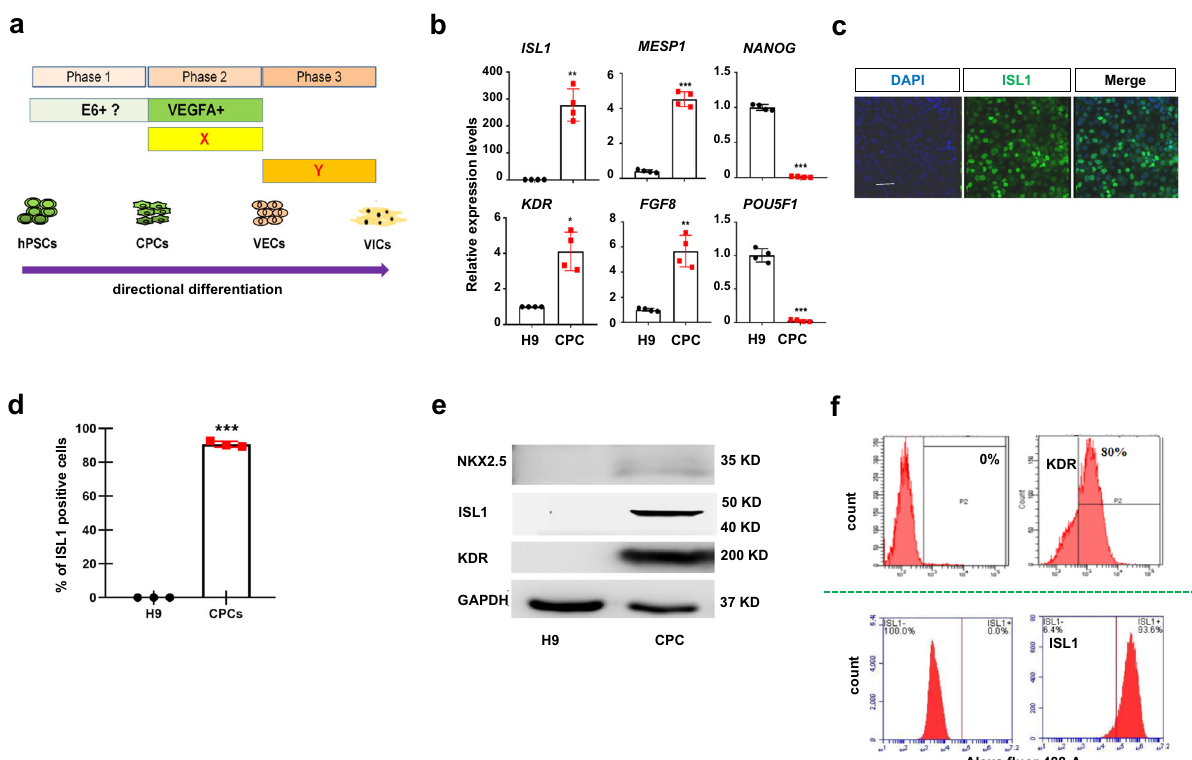
Fig. 1 PSCs to cardiogenic mesoderm expressing KDR and ISL1. a Schematic of differentiation hPSCs to CPCs, VEC-like cells, and VIC-like cells. X indicates the future cytokines or small molecules for phase 2; Y indicates the future cytokines or small molecules for phase 3. b The qPCR analysis of day 3 hPSC-derived CPCs for the indicated markers. c IF staining of day 3 CPCs showing that the majority of cells were ISL1 positive. Scale bar: 50 μ m. d Quanti fi cation analysis of IF staining of ( c ) by ImageJ. Bar graph represents percentage of ISL1 positive cells ± S.D of three independent experiments. e WB analysis of day 3 CPCs using the indicated antibodies. f Flow cytometry analysis showing the percentage of KDR and ISL1 positive cells, respectively. All experiments were repeated 3 times. The paired t test in Graphpad software was used for the statistical analysis. Signi fi cant levels are: * p < 0.05; ** P < 0.01; *** P < 0.001. Shown are representative data in ( c , e